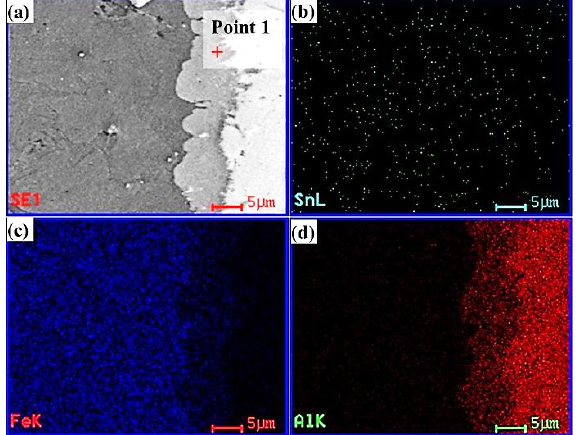
Figure 9. SEM image and EDS map elemental distributions of steel — Al alloy coating interface for steel with Sn pre-treatment surface and dipping time of 30 s, ( a ) SEM image, ( b ) Sn map, ( c ) Fe map, ( d ) Al map.